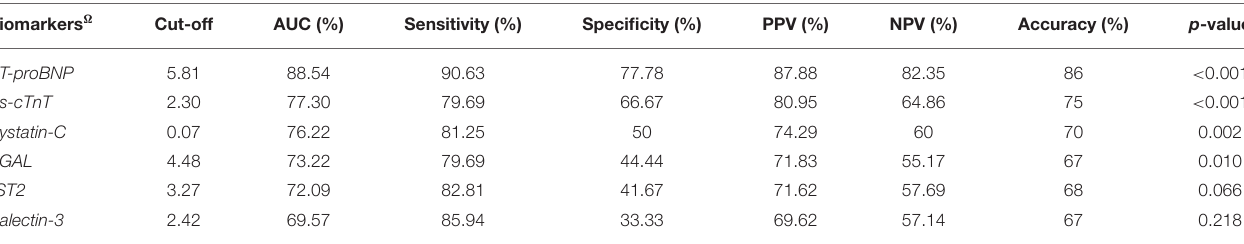
TABLE 4 | Discriminative characteristics of the evaluated biomarkers for DD in the context of chronic Chagas cardiomyopathy. Biomarkers